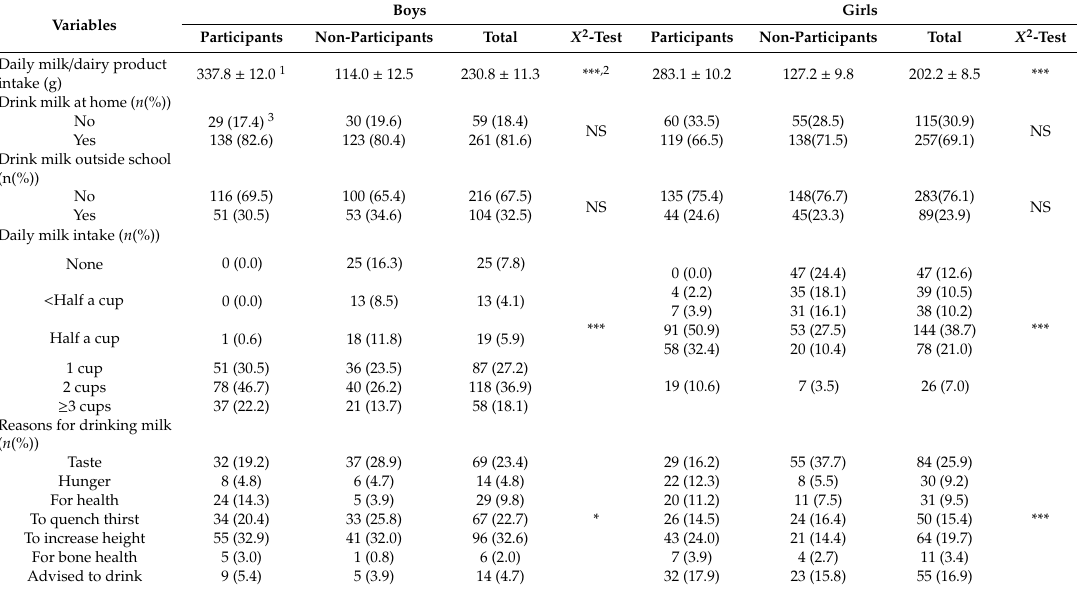
Table 2. Milk consumption status of participants and non-participants in the school milk program in South Korea. Boys Girls Variables Participants Non-Participants Total X 2 -Test